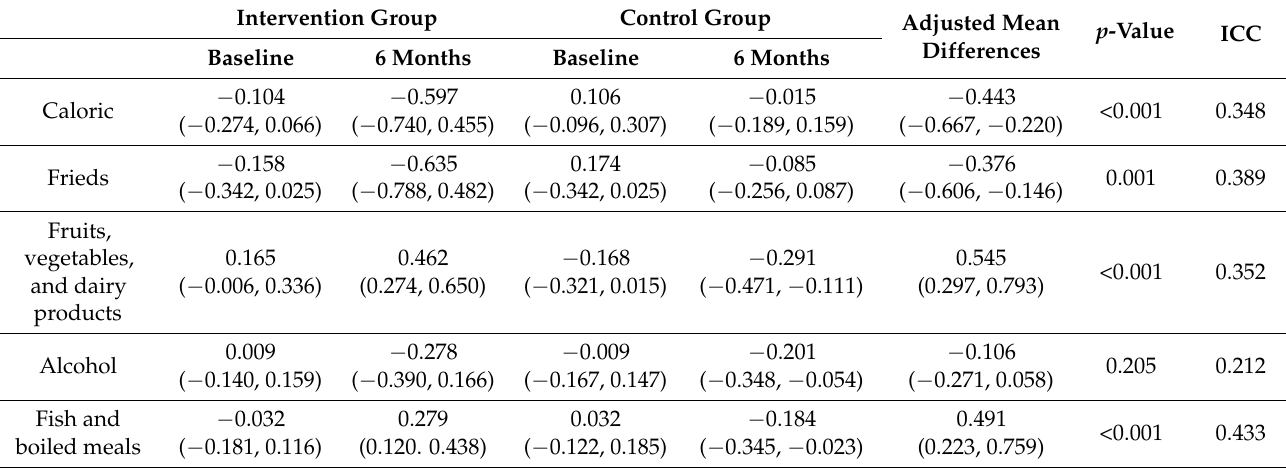
Figure 3. Changes in dietary pattern scores after the 6-month intervention. Table 5. Comparison of dietary pattern differences between the intervention and control groups after 6 months.